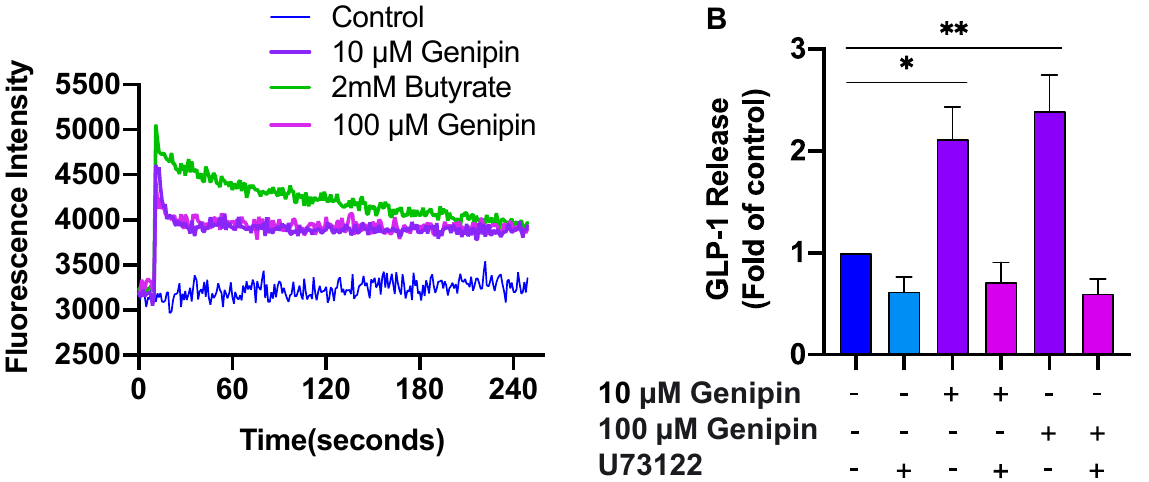
Figure 2. Genipin-induced GLP-1 release was mediated via the PLC/Ca 2+ signaling pathway. ( A ) Suspended GLUTag cells were pretreated with Fluo-4AM and then incubated with genipin (10 μ M, 100 μ M), butyrate (2 mM), or control. The [Ca2+] i response was measured using a fluorescence plate reader. A representative image from 3 independent experiments is shown. ( B ) GLUTag cells were pretreated with 10 μ M U73122 for 30 min, followed by the addition of genipin (10 μ M, 100 μ M) or vehicle for another 1 h. Supernatants were collected for GLP-1 measurement. Data are presented as means ± SEM (n = 3). * p < 0.05 and ** p < 0.01 vs. control.